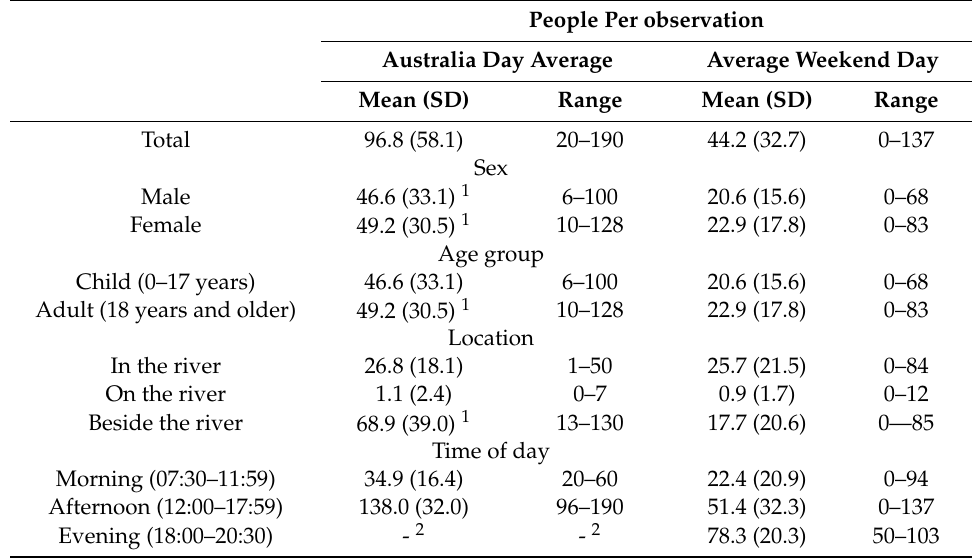
Table 4. Results of Australia Day observations, compared to average weekend day.